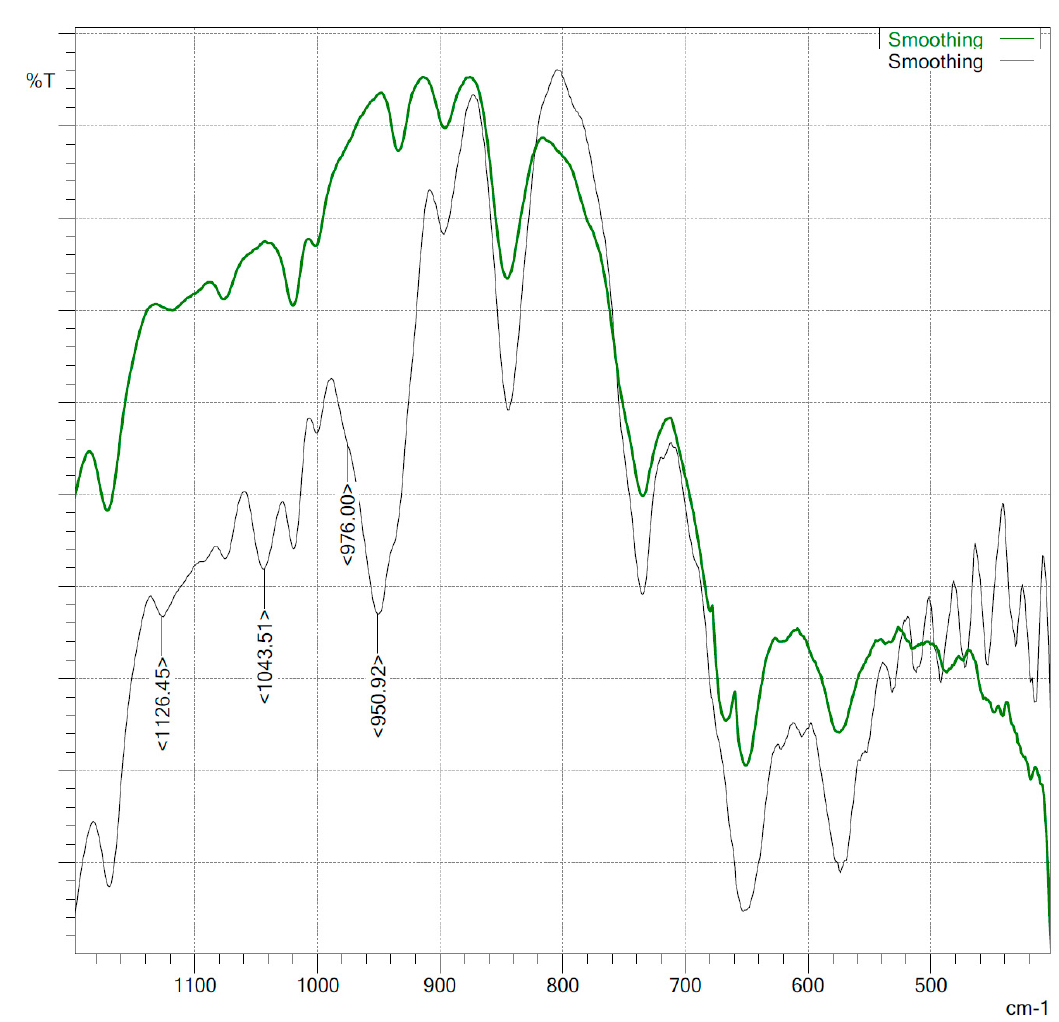
· HCl (grey) andVP–VDTC